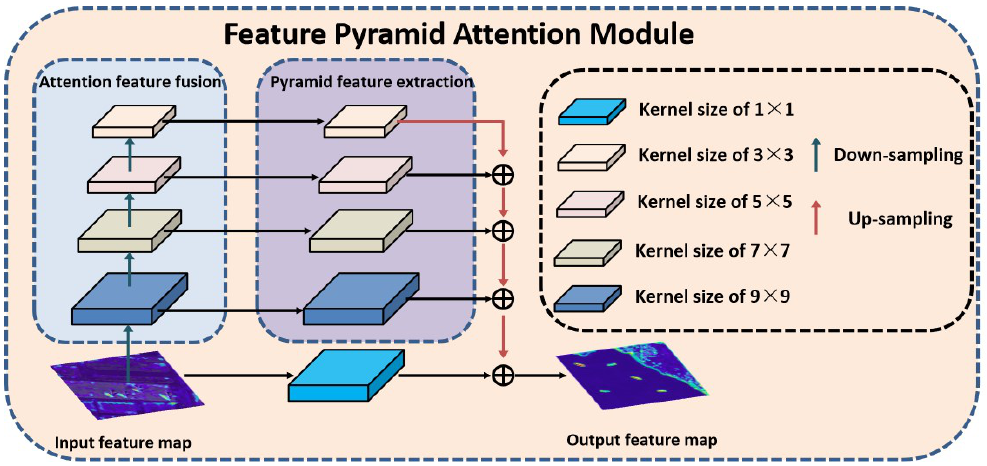
Figure 4. The structure of feature pyramid attention mechanism (FPAM), including the Attention Feature Fusion (AFF) Module and Pyramid Feature Extraction (AFF)